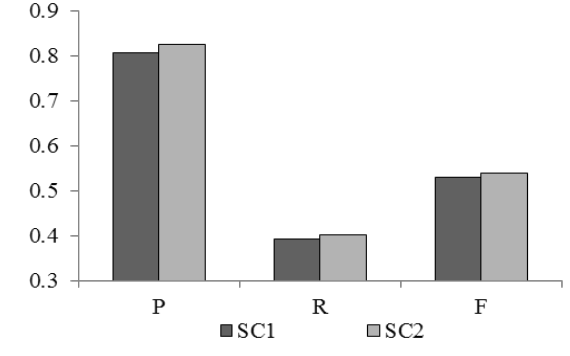
Fig. 8. Semantic code research on